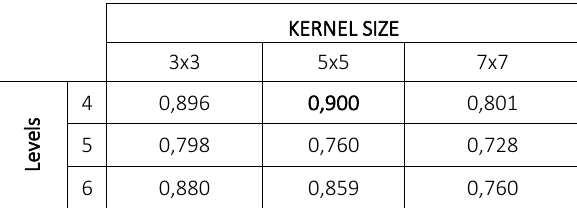
Table 1: SMMI value for the checked combinations of levels in the encoder path and kernel size KERNEL SIZE